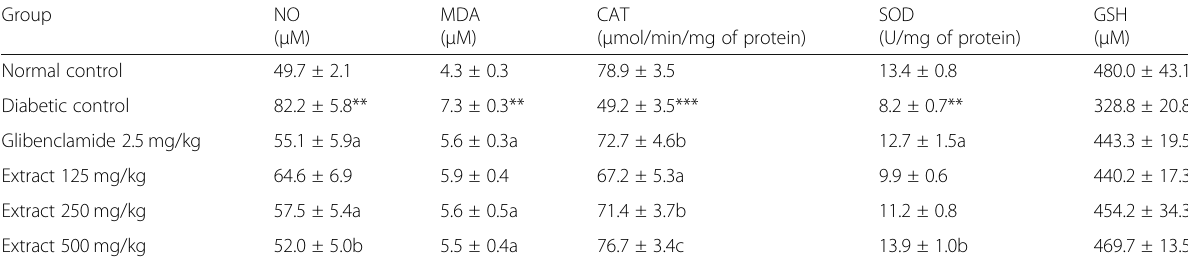
Table 5 Effect of Vitellaria. paradoxa on antioxydant parameters